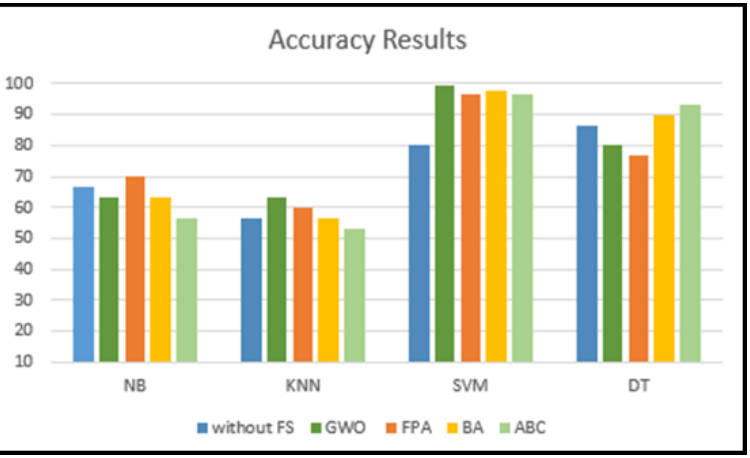
Figure 10. Comparison of accuracy between Experiment 1 and Experiment 2 on GE dataset.